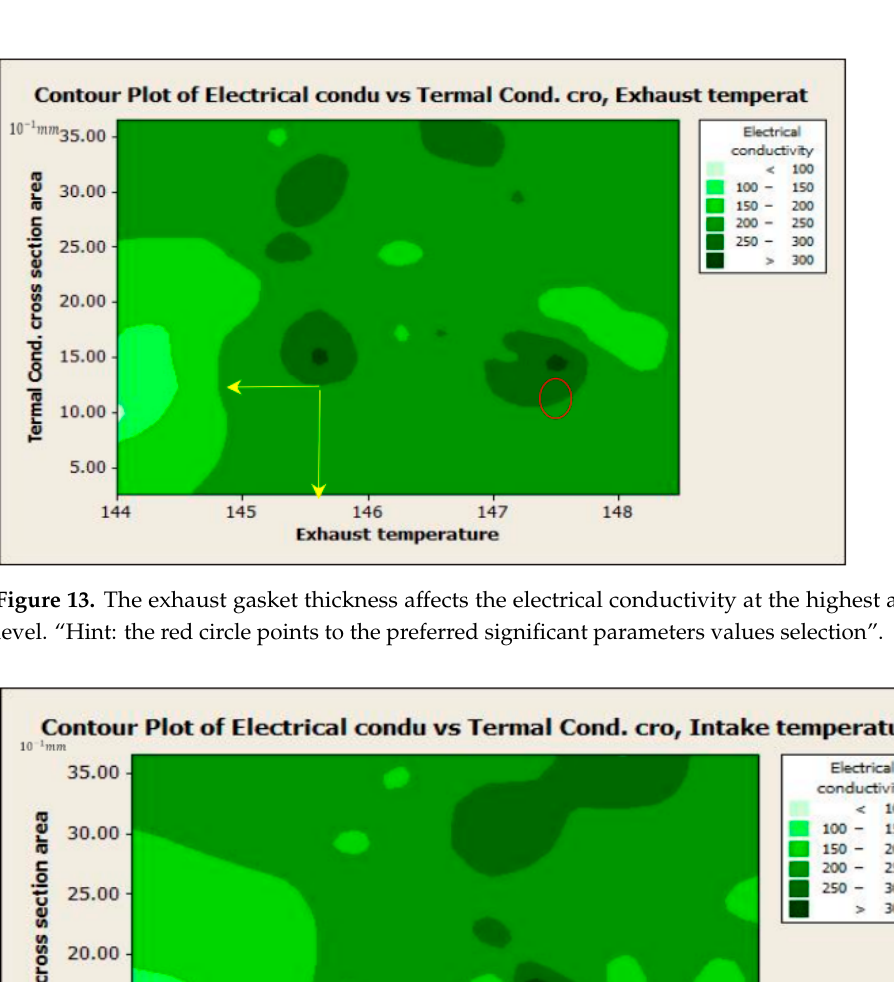
Figure 15. The strip cross section for TEG legs affects the cracks’ span. Hint: points to the preferred significant values